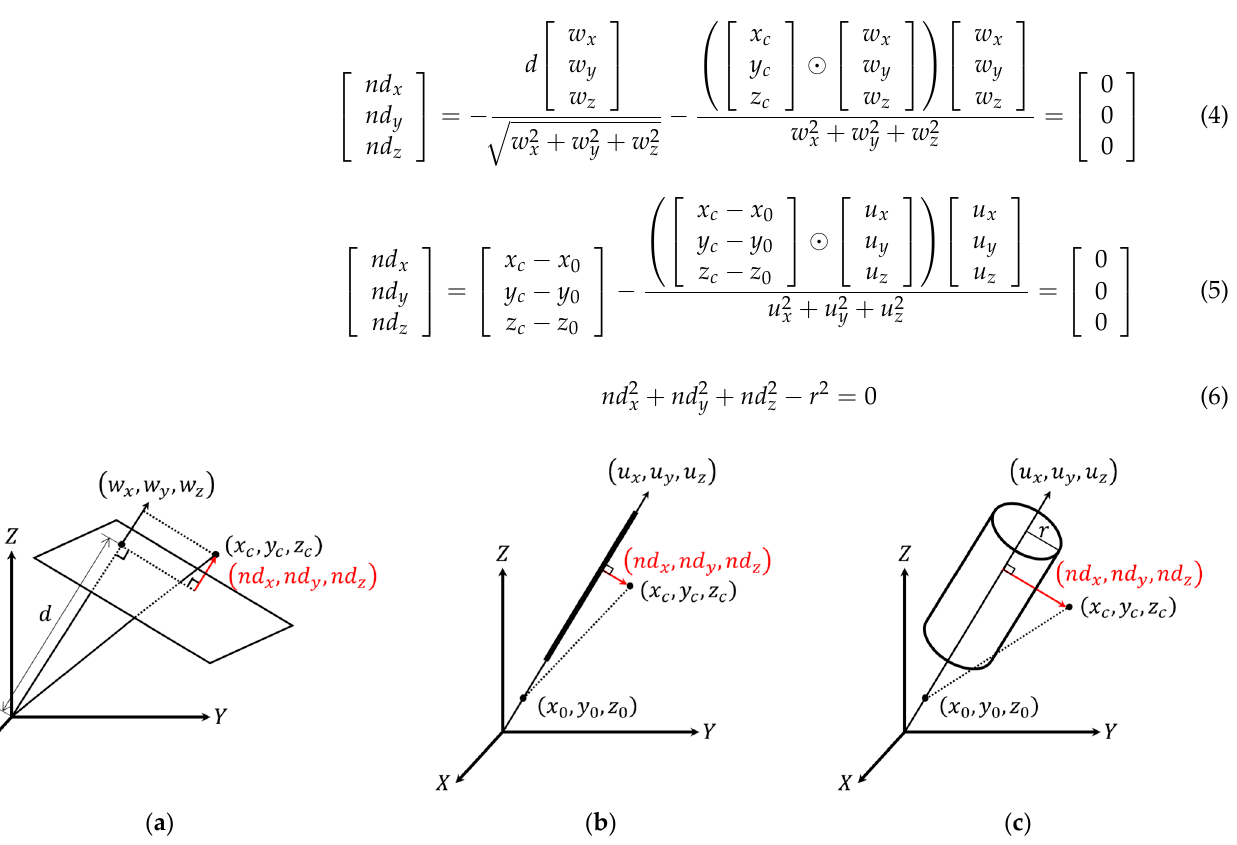
Figure 9. Schematic illustration of the normal distance vector components that are minimized using the ( a ) plane-fitting model, ( b ) 3D line-fitting model, and ( c ) cylinder-fitting model.